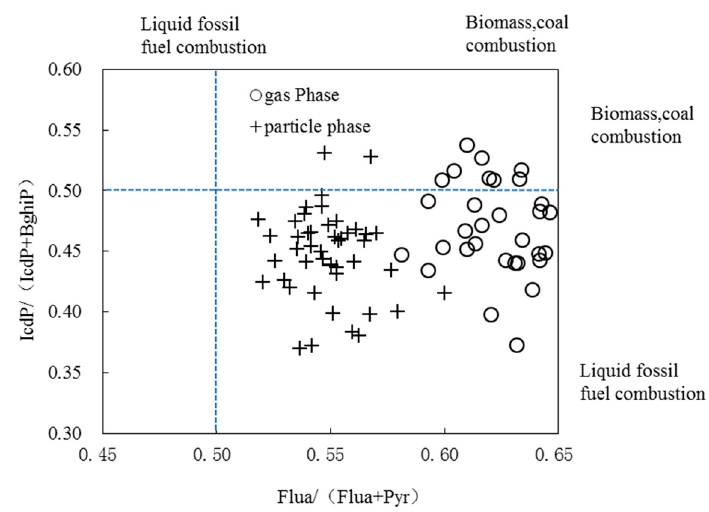
Figure 3. The diagnostic ratio of Flua/(Flua + Pyr) plotted against IcdP/(IcdP + BghiP) obtained for gas and particle samples. The division between completely liquid fossil fuel combustion sources and biomass/coal burning are indicated by dotted lines.